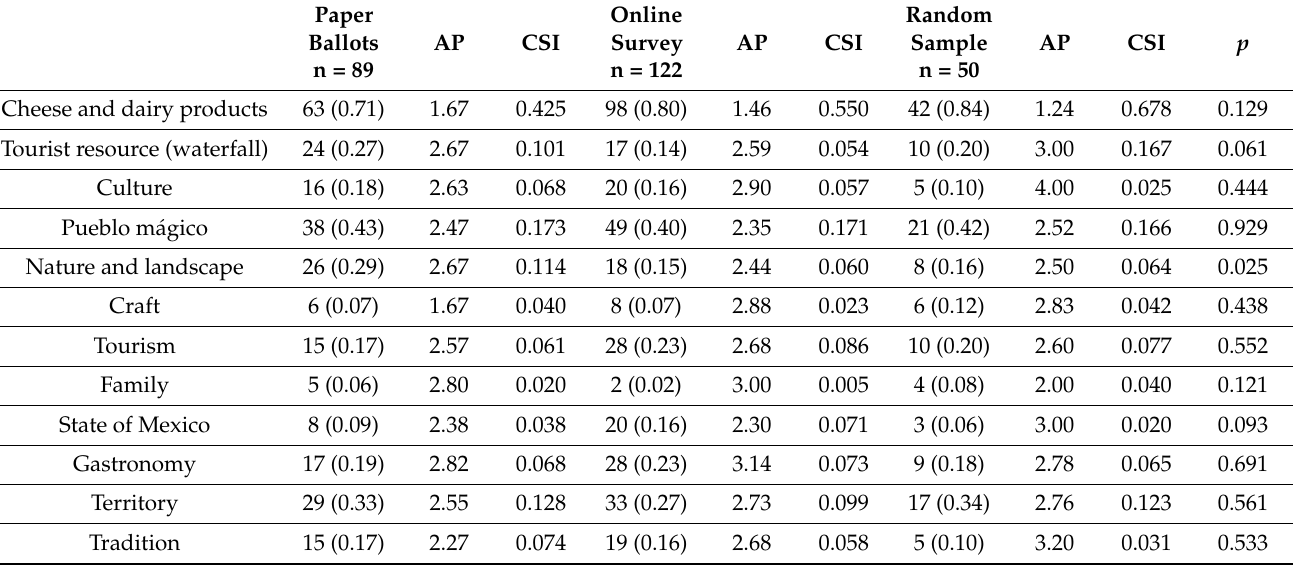
Table 2. Stability and validity of social representations from the three study